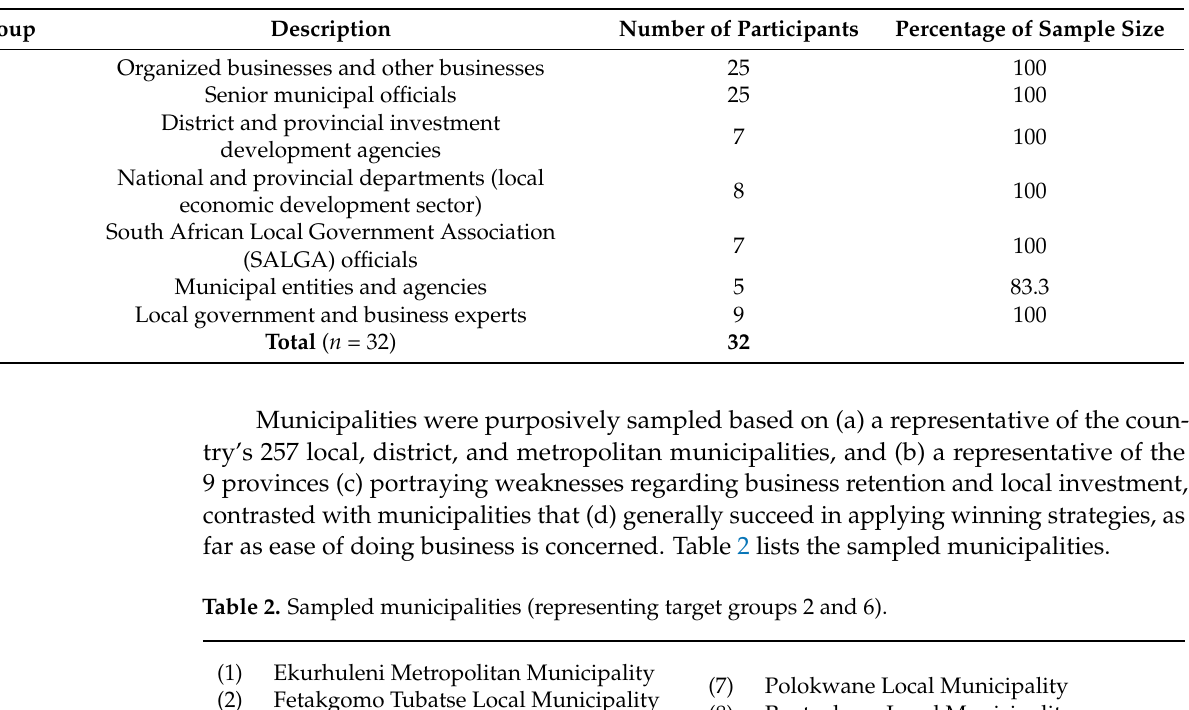
Table 1. Target groups.